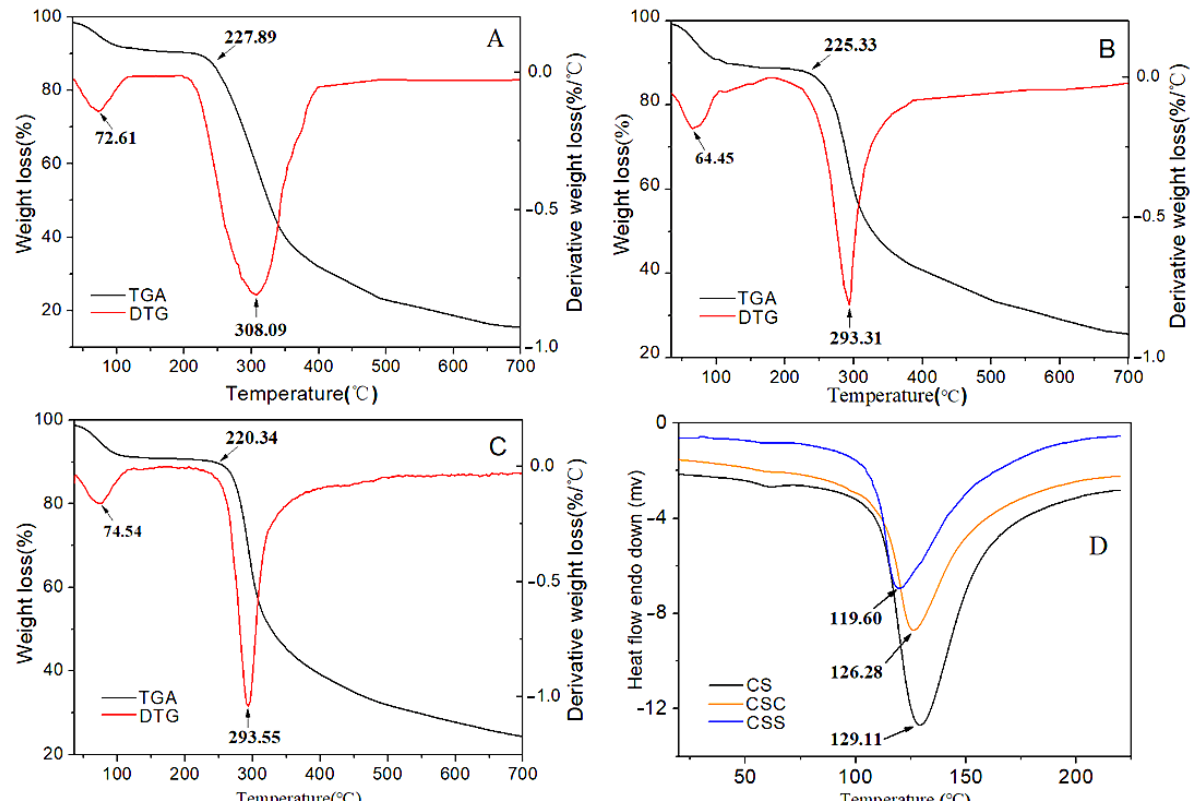
Figure 4. Thermogravimetric analysis (TGA) and derivative thermogravimetric analysis (DTG) curves of commercial chitosan (CS) ( A ), crab chitosan (CSC) ( B ), squid chitosan (CSS) ( C ) and differential scanning calorimetry (DSC) spectra of chitosan ( D ).